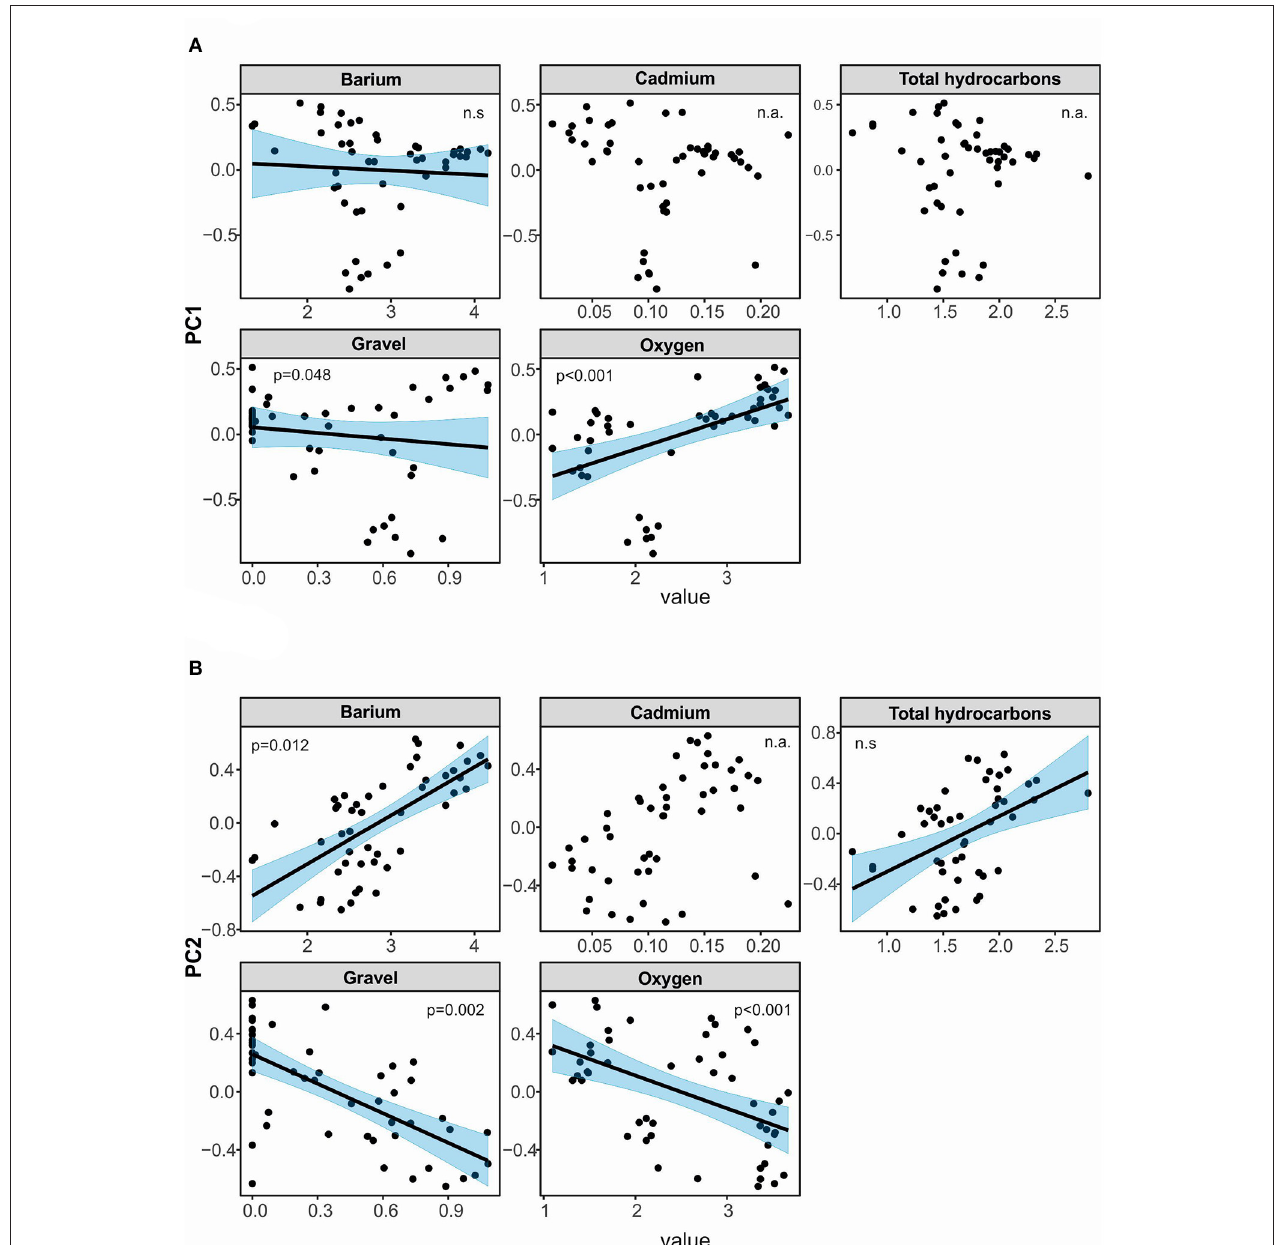
FIGURE 7 | Visualization of linear models testing for effects of selected environmental factors on species composition of cumaceans, expressed as site scores along PCA ordination axis 1 (A) and axis 2 (B) . Phrase “n.a.” means that environmental factor was not included in a set of the most parsimonious models. Phrase “n.s.” means its explanatory power was not significant despite the fact that means environmental factor was included in a set of the most parsimonious